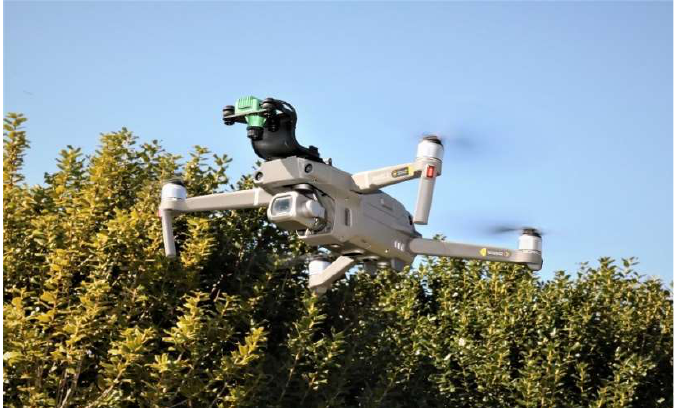
Figure 1. DJI Mavic air UAV with single NDVI camera over the crapemyrtle ( Lagerstroemia spp.) field at Tennessee State University, Otis L. Floyd Nursery Research Center, McMinnville, TN for automatic detection of drought stress in the plants.